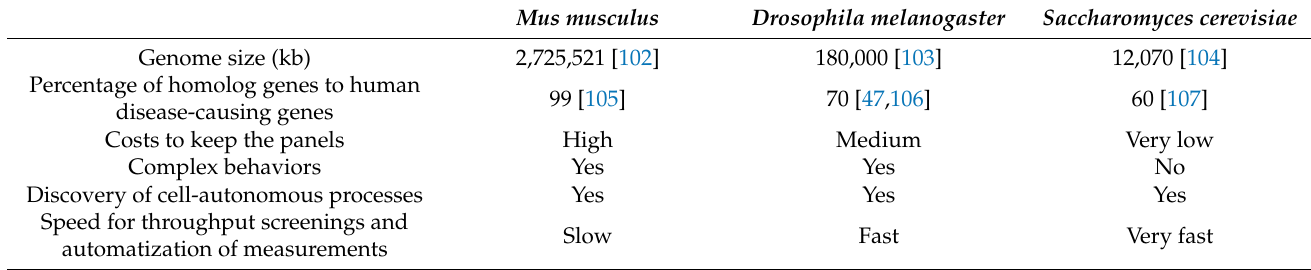
Table 1. Practical considerations for choosing model organisms and their panels. The references are shown in brackets. When deciding the best model for a project, variables such as the percentage of homolog genes to human disease-causing genes, costs, and the possibility of automatization should be